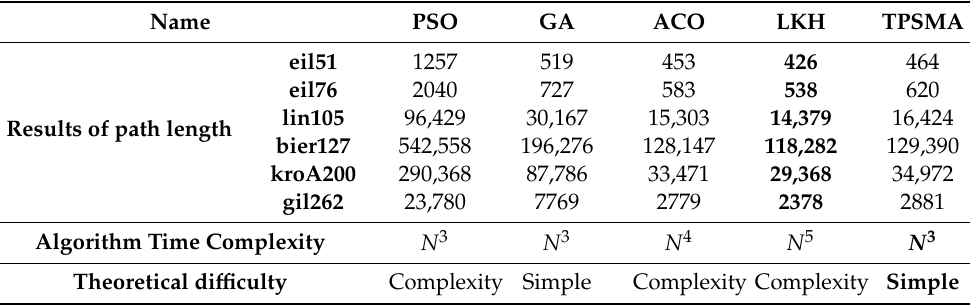
Table 5. Comparisons of optimization results and algorithm features.